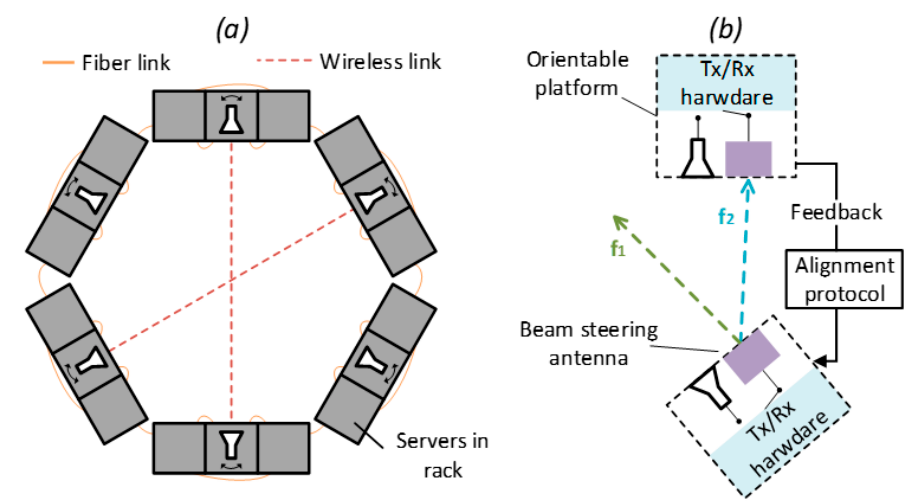
Figure 11. ( a ) Hybrid interconnections in a data center; the continuous yellow lines represent wired fiber links whereas the dashed red lines illustrate reconfigurable wireless LoS links. ( b ) LWA set-up, co-located with the wireless transceivers, to enable alignment in a LoS link.